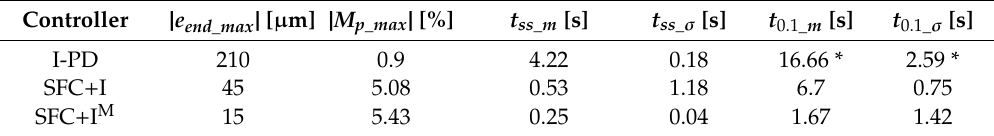
Table 5. Positioning performance metrics: comparison between different controllers.